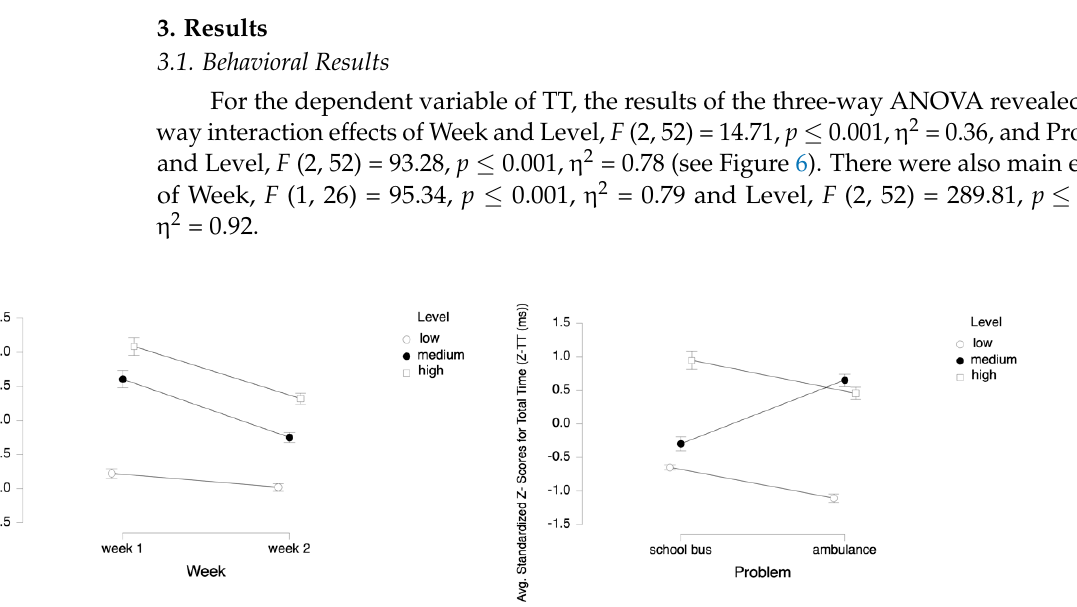
Figure 6. Line plots represent interaction effects of Level and Week (left) and Level and Problem (right) on average standardized z scores for total time (Z-TT) with the error bars representing the standard error of the mean statistic. Differences in average Z-TT (ms) are represented across low, medium, and high cognitive load tasks for Week 1 and Week 2 and for School Bus and Ambulance problem scenarios.